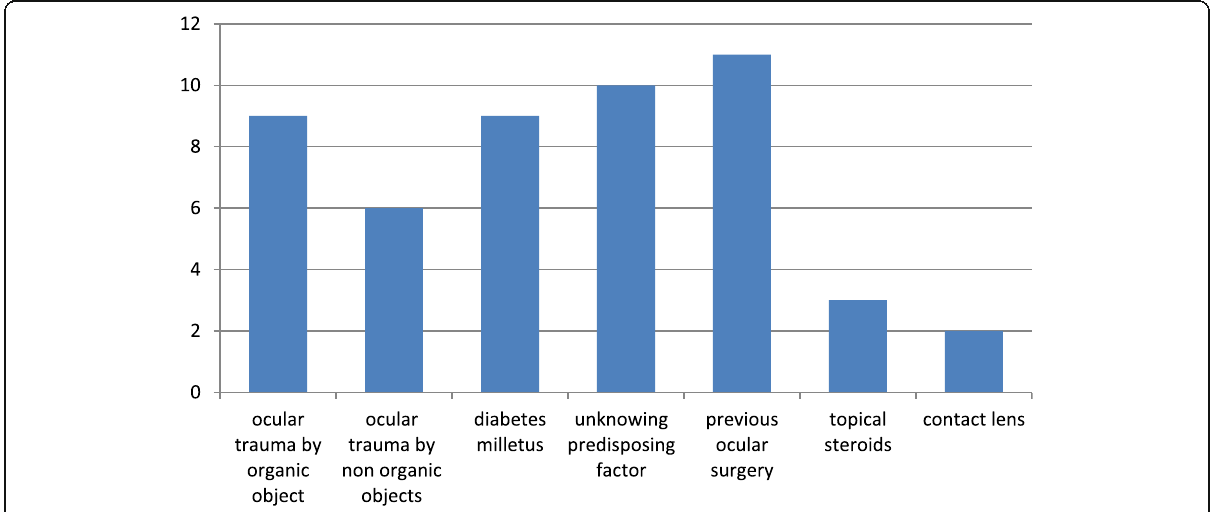
Fig. 1 Distribution of predisposing factors for keratitis among the studied